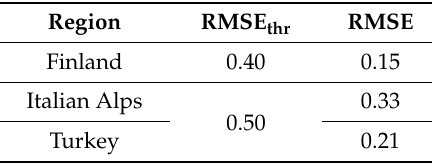
Table 12. Overall RMSE values for the comparison between S-2-derived FSC maps and H12 product. H12 product requirement for both flat (i.e., Finland) and mountainous areas (i.e., Italian Alps, Turkey) (RMSE thr ) is reported [105]. Region RMSE thr